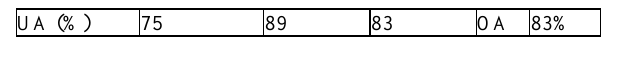
Table 10. Confusion matrix obtained for the filtered classification. OA (Overall Accuracy), PA (Producer’s Accuracy) and UA (User’s Accuracy).